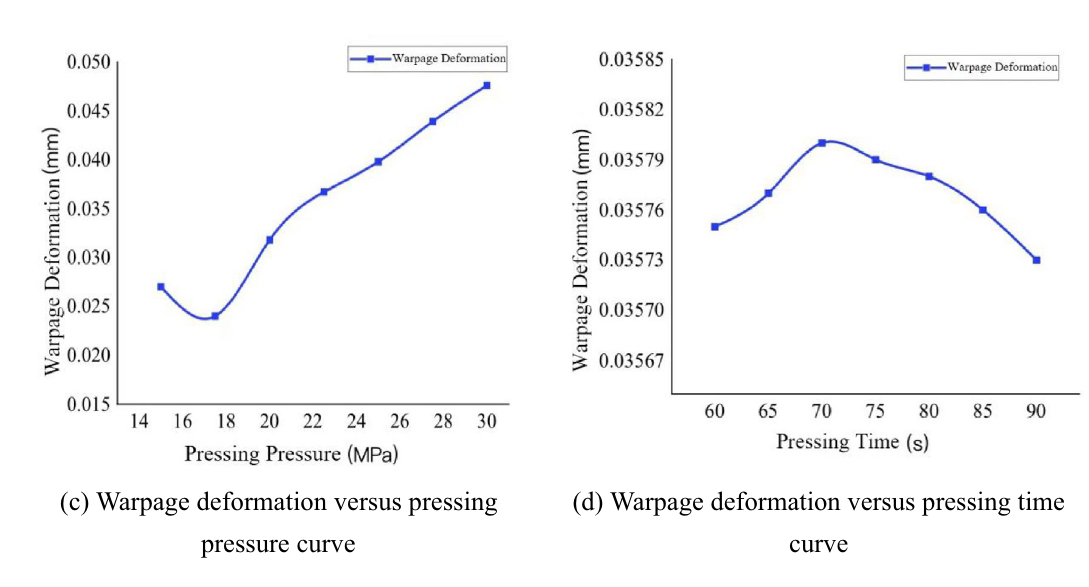
Figure 22. Warpage deformation curve with process